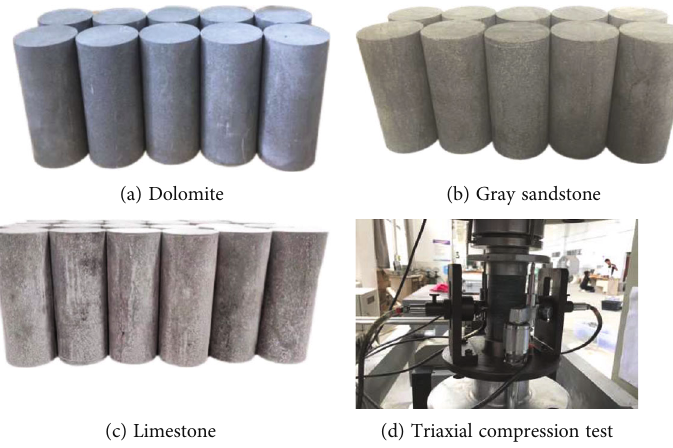
Figure 1: Standard specimens and parameter determination process. Table 1: Basic mechanical parameters of rock mass.